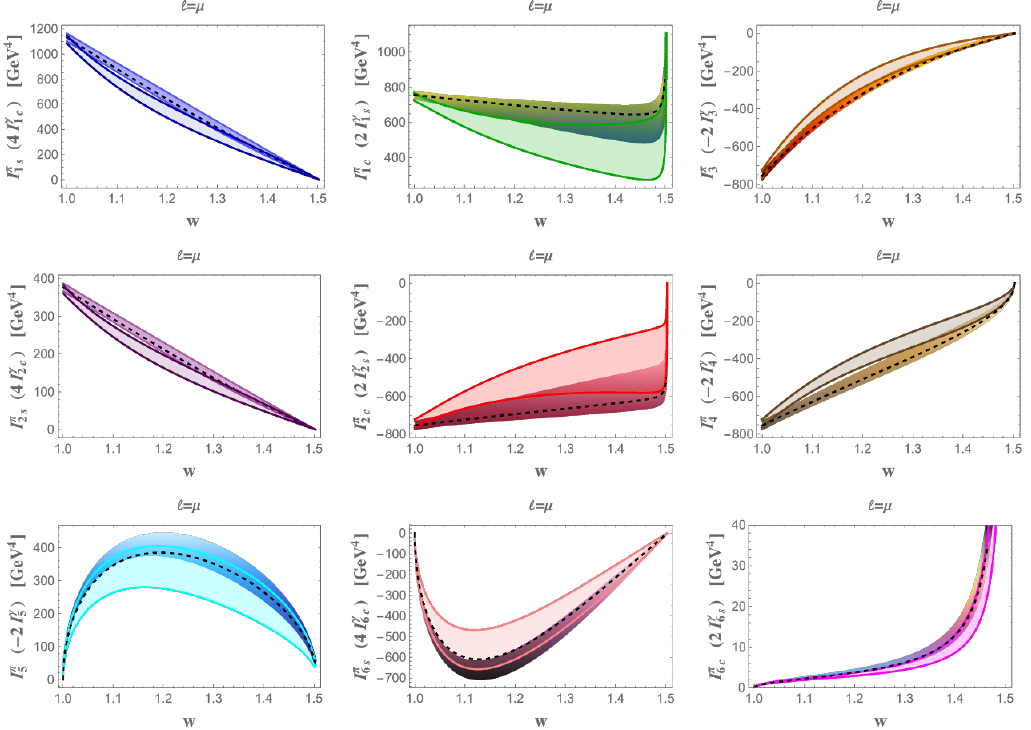
Figure 2 . Angular coe(cid:14)cients in the fully di(cid:11)erential decay distribution eq. (3.1) for ‘ = (cid:22) in SM. The coe(cid:14)cients in (3.2) are obtained using the relations (3.5). The darker regions correspond to the CLN parametrization with parameters in table 1, the lighter regions to the BGL parametrization described in appendix B. The dashed lines are the HQ predictions.